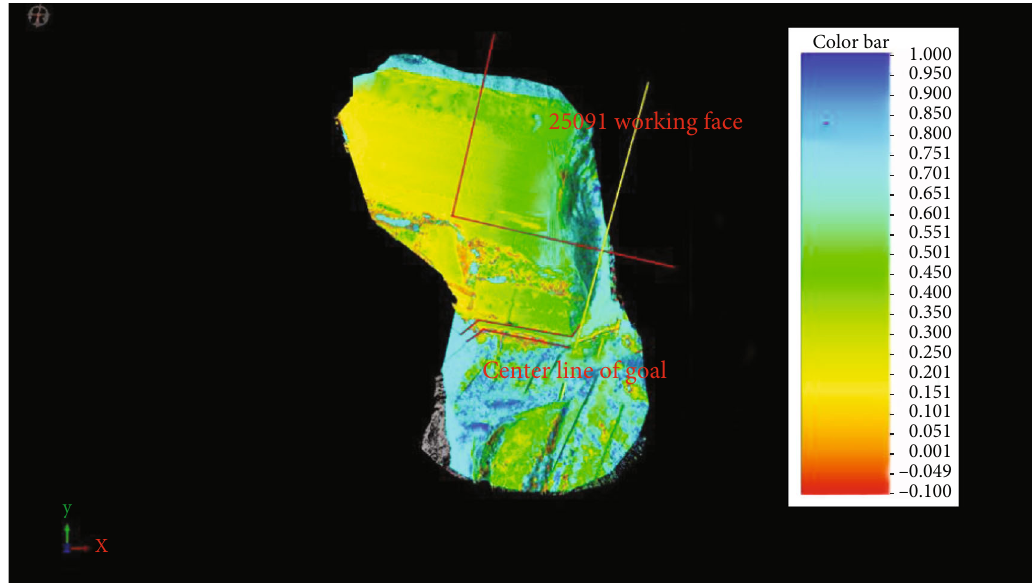
Figure 11: Comparison of point cloud DEM in the third and third